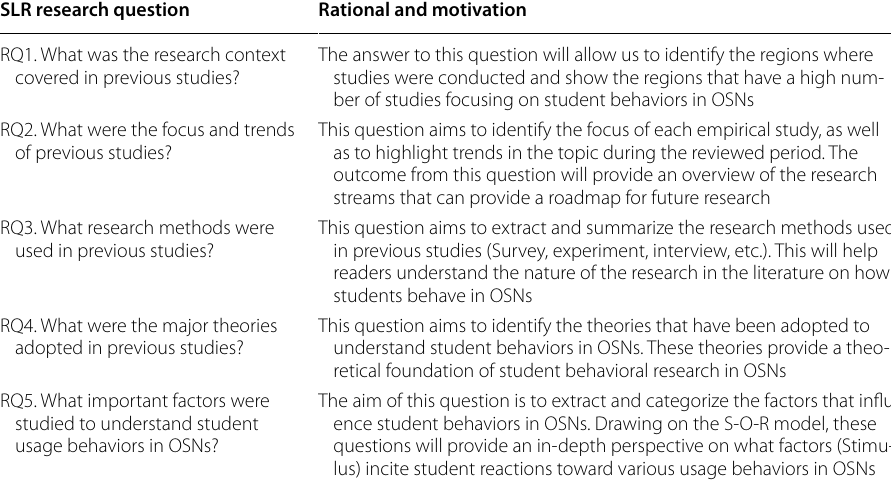
Table 1 SLR research questions and